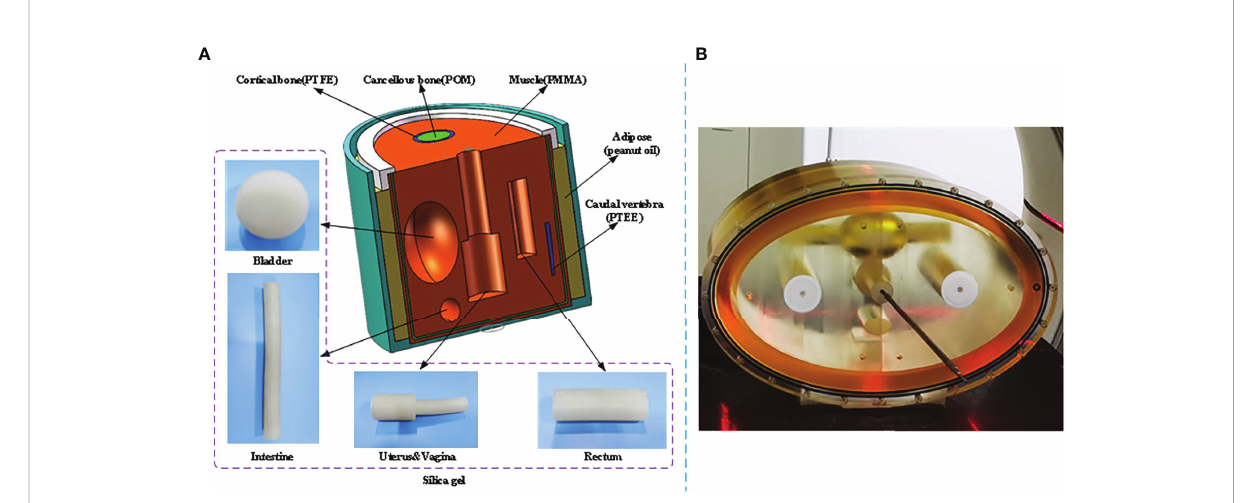
FIGURE 2 Illustration of the self-developed female pelvis BT phantom. (A) Structure diagram and materials of the phantom. (B) Pelvis phantom during a real CT